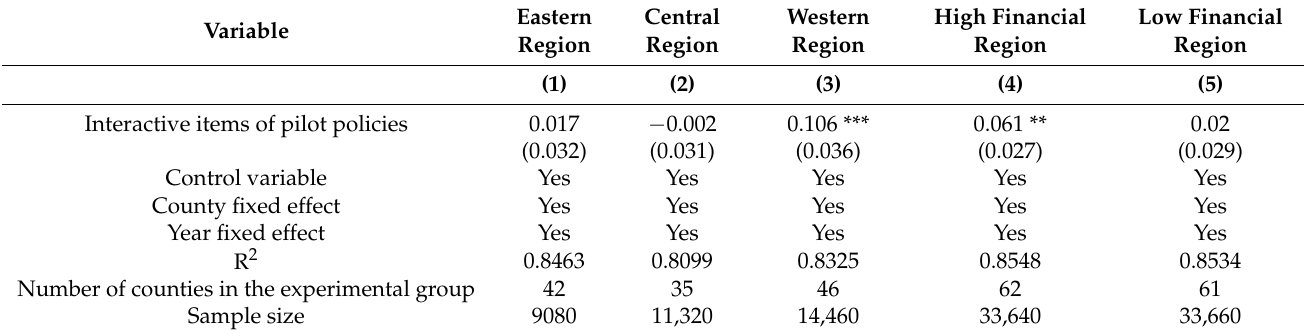
Table 6. Heterogeneity